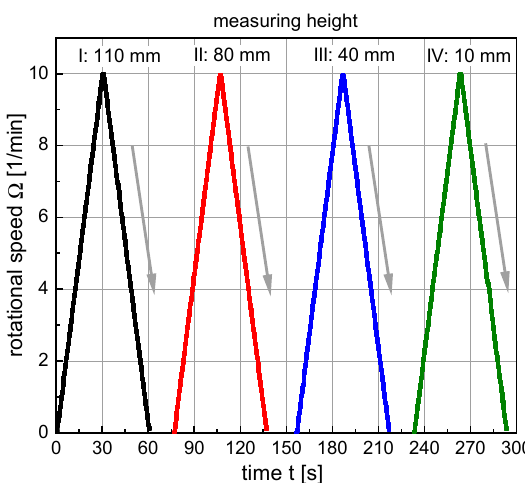
Figure 4. Rheometer measuring program. The downward ramp, marked by arrows, was used for data evaluation.